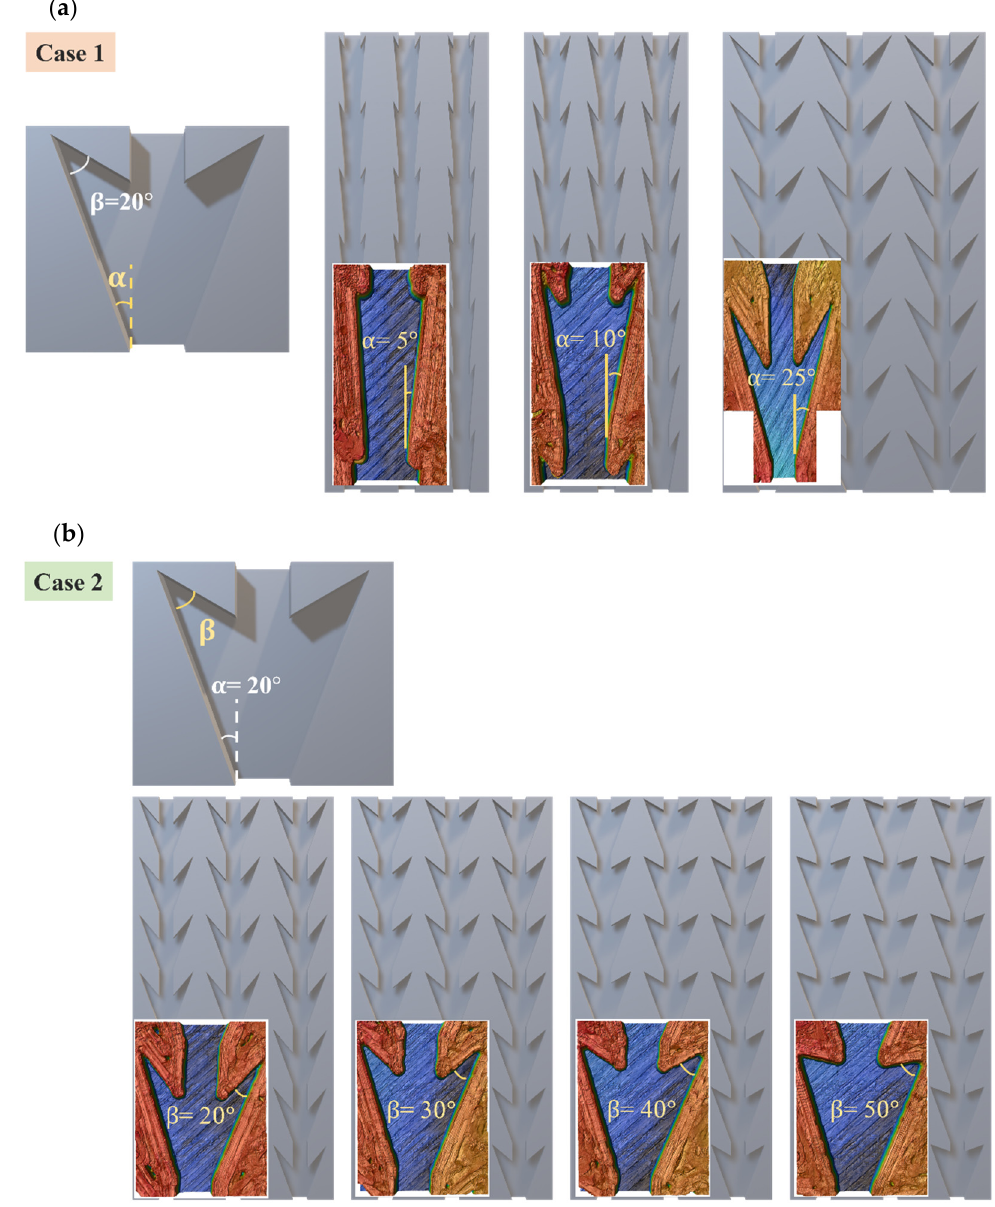
Figure 6. The patterns with different ( a ) α angles; ( b ) β angles and the laser confocal images (color images) show the structural contour of the design structure (gray image). The pattern is 42 mm in total length.